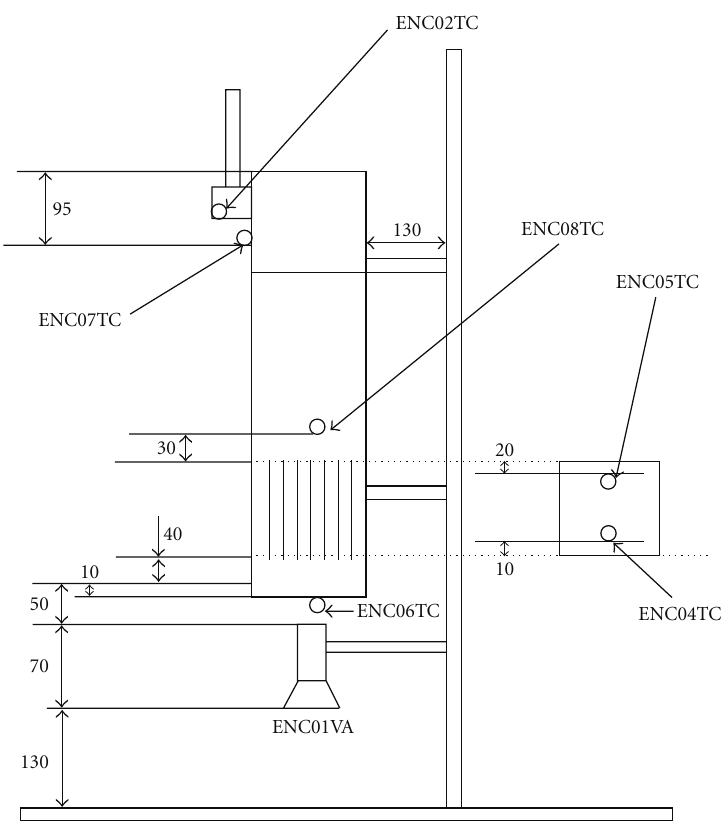
Figure 8: Sketch of KALI-H 2 test.